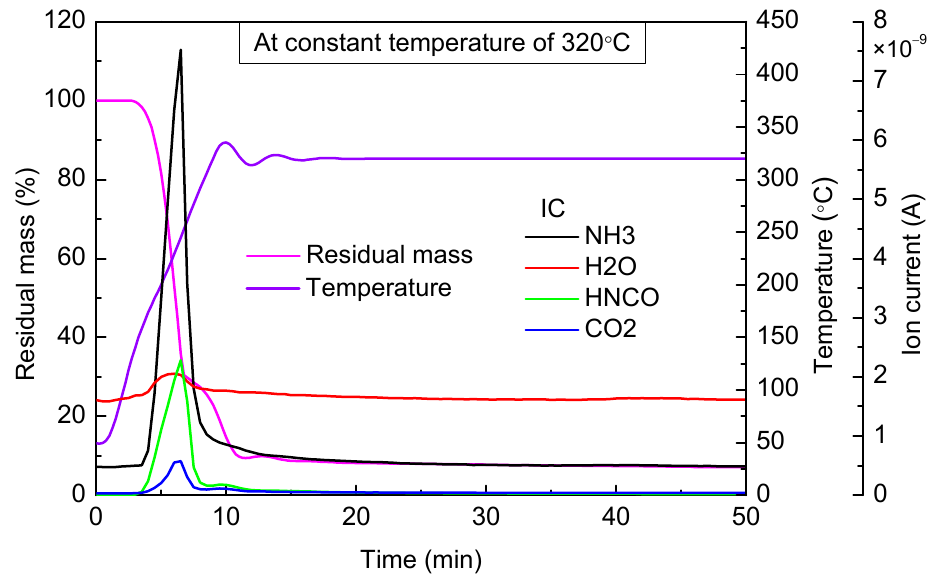
Figure 8. TG-MS results of urea at constant temperature of 320 °C.